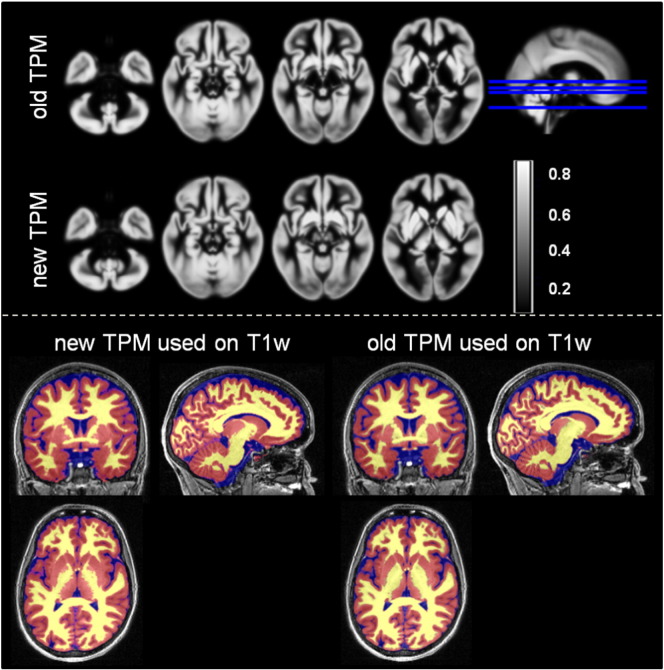
Top panel: axial view on the new and the conventional tissue probability maps (TPMs) for gray matter. Bottom panel: example of tissue classification from T1-weighted data using the new and the conventional TPMs. The gray matter probability maps is represented in red, the white matter—in yellow and the cerebro-spinal fluid (CSF)—in blue.